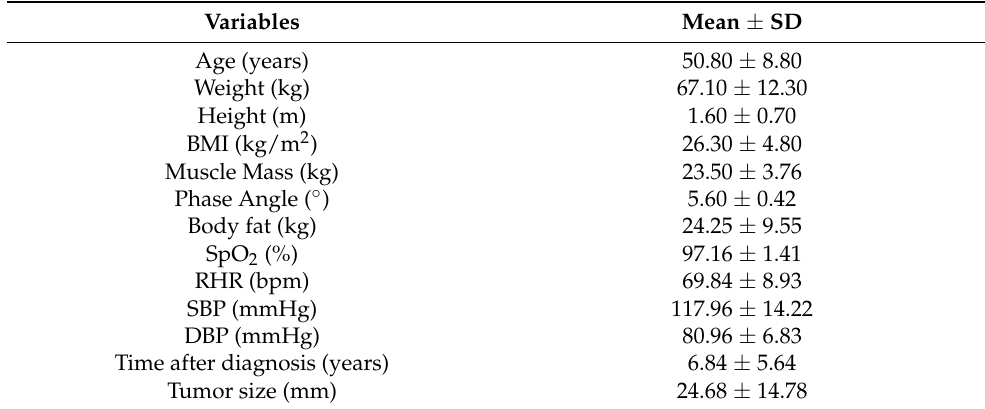
Table 1. Demographic and physiologic characteristics of the study participants.